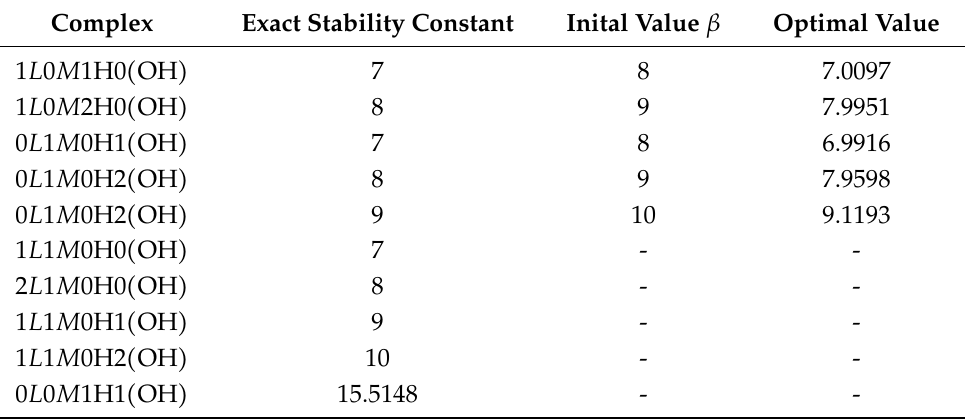
Table 2. Decadic logarithms of the results of the exact values, initial values, and optimal values.